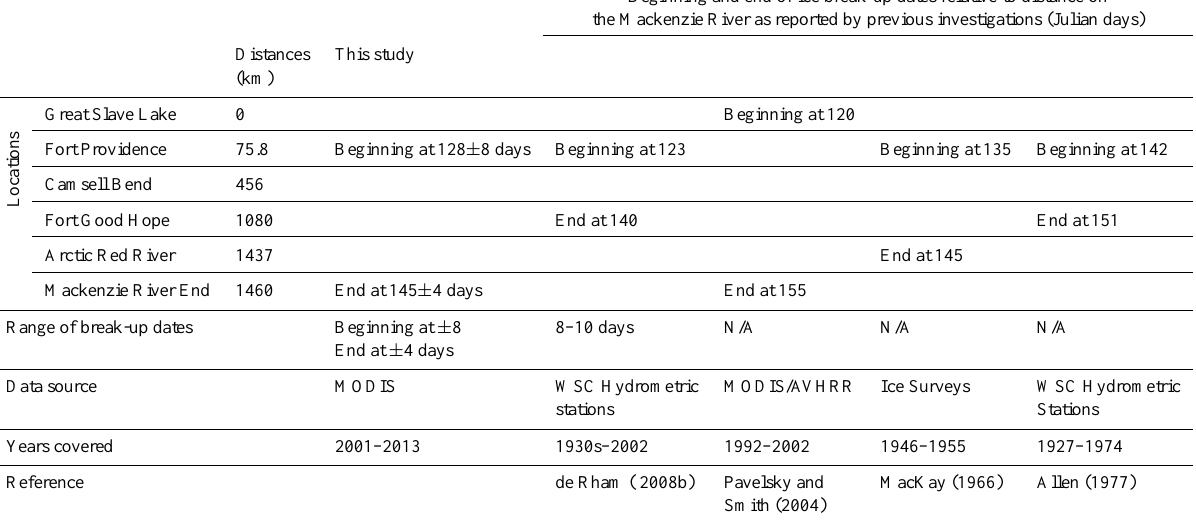
Table 4. Summary of results from previous investigations and this study showing the beginning and end of the ice break-up period with respect to location and range and duration of period. Also shown are the sources of data used, years covered for analyses and corresponding